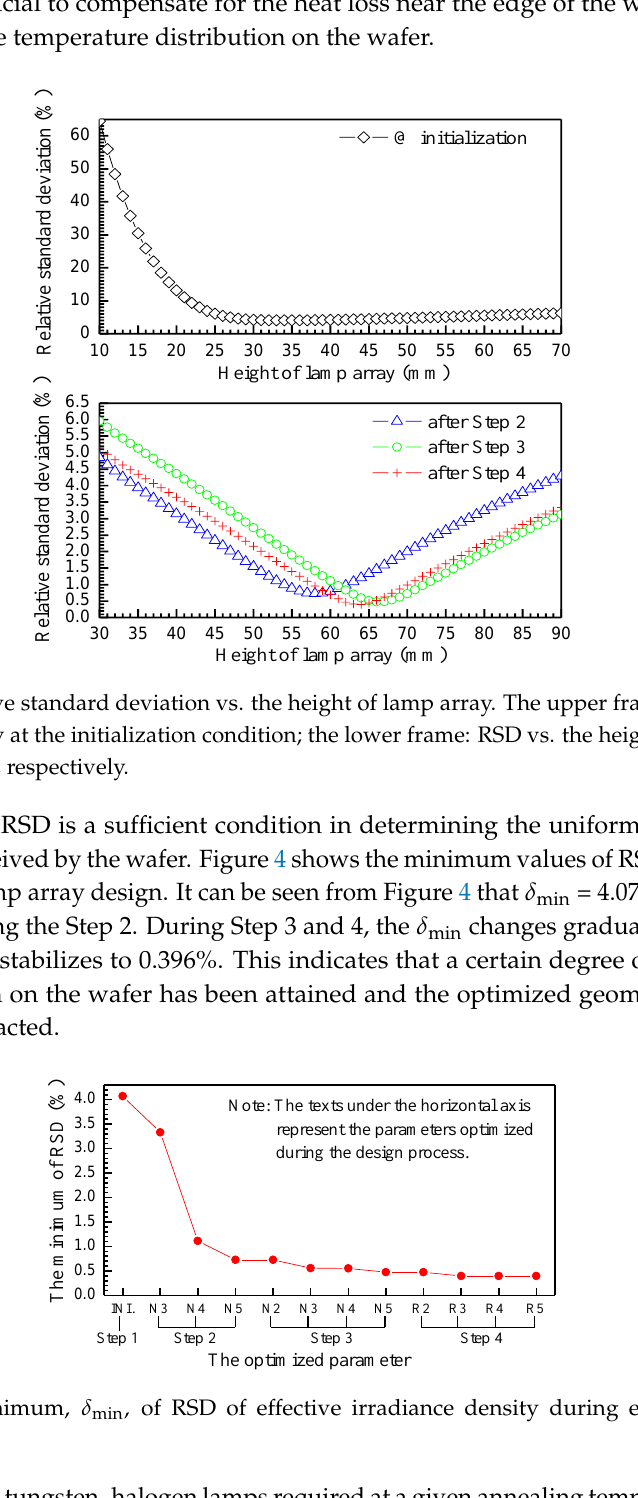
Figure 4 . The minimum, δ min , of RSD of effective irradiance density during each sub-step of optimal design.